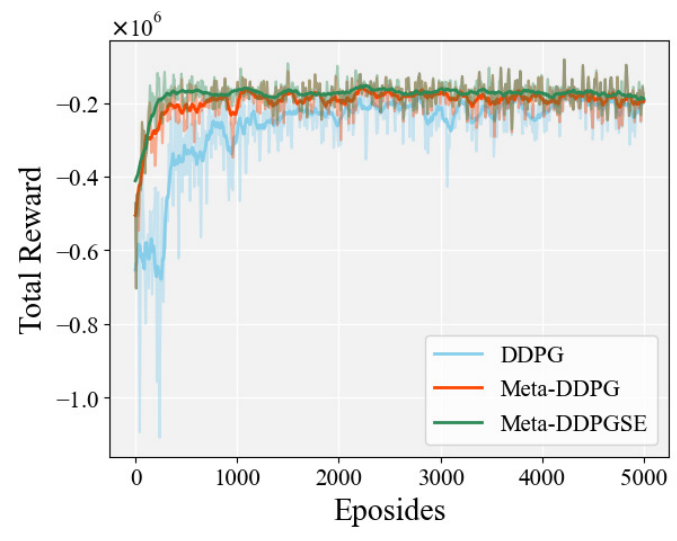
Figure 6. The total reward trends in the